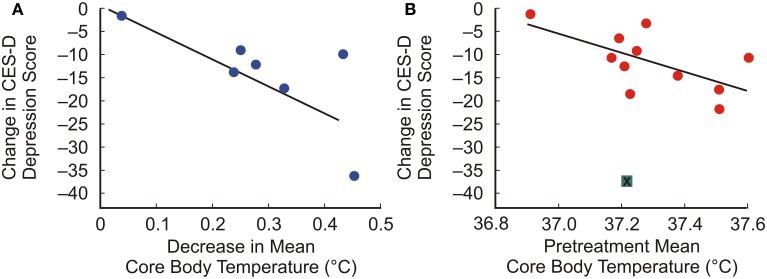
Associations between 24-h mean core body temperature and depressive symptom response to whole-body hyperthermia. (A) Scatterplot illustrating the correlation between decreases in score on the Center for Epidemiologic Studies Depression Scale (CES-D) and decreases in 24-h mean core body temperature from before treatment to 5 days after treatment with whole-body hyperthermia. (B) Scatterplot illustrating the correlation between 24-h mean core body temperature before treatment and changes in CES-D depression scores from before treatment to 5 days after treatment, with one outlier removed (indicated by a green box with an “x” through it). Adapted from Hanusch et al. (2013), with permission.